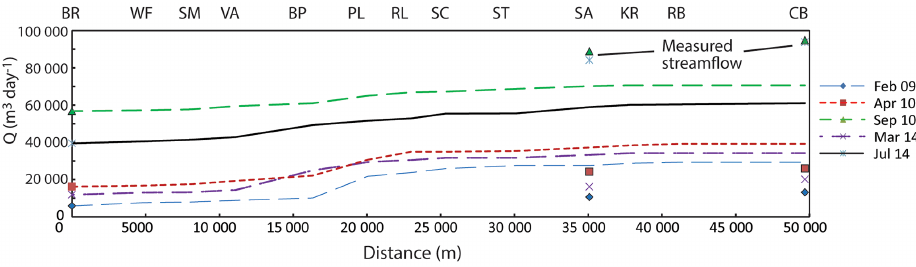
Figure 9. Calculated streamflows resulting from groundwater inflows for the sampling rounds excluding February 2015 estimated without parafluvial flow. Aside from the high flow periods (September 2010 and July 2014) the calculated increase in streamflow exceeds the observed streamflow at Stratford and Chinns Bridge. Site abbreviations are as for Fig.